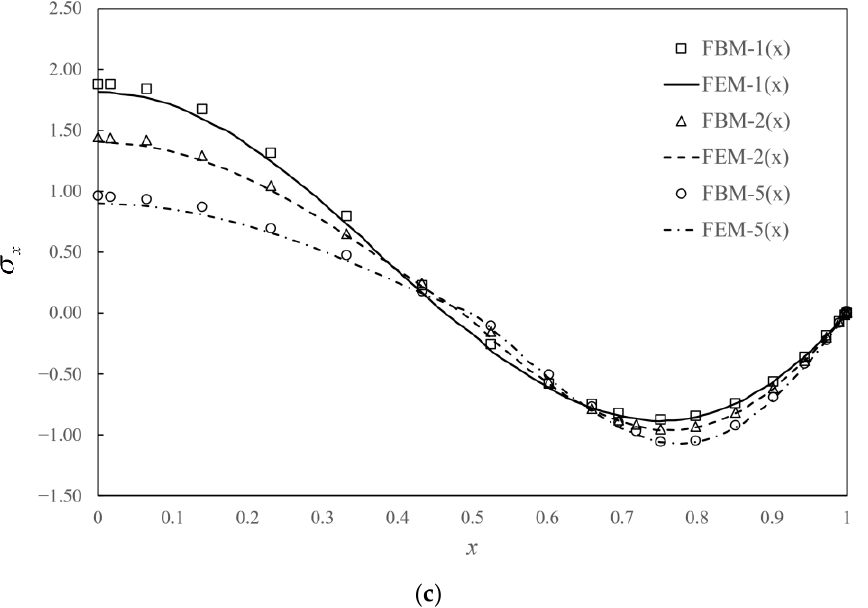
Figure 9. Dimensionless stress with 3 different ratios of Young’s moduli in tensile and compression along ( a ) AB; ( b ) CD; ( c ) AC and “n × ”: E − / E + = n.